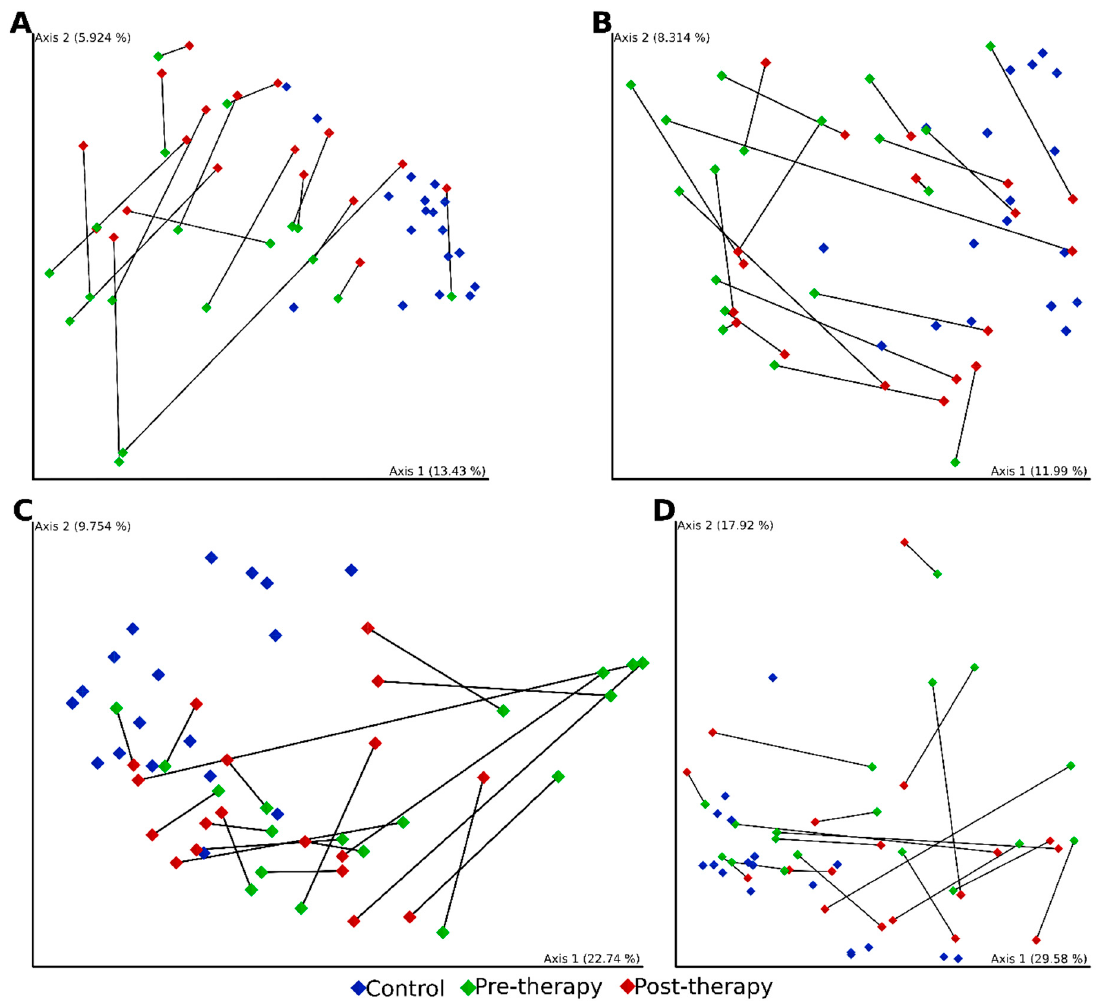
Figure 2. PCoA 2D plots of beta diversity analysis of control and patients with CD pre- and post-IFX therapy. Beta diversity was measured by Jaccard distances ( A ), Bray–Curtis distance ( B ), unweighted UniFrac distances ( C ) and weighted UniFrac distances ( D ). Colors indicate groups: control—blue; patients with CD pre-IFX therapy—green; patients with CD post-IFX therapy—red. Lines connect paired samples from the same individual.